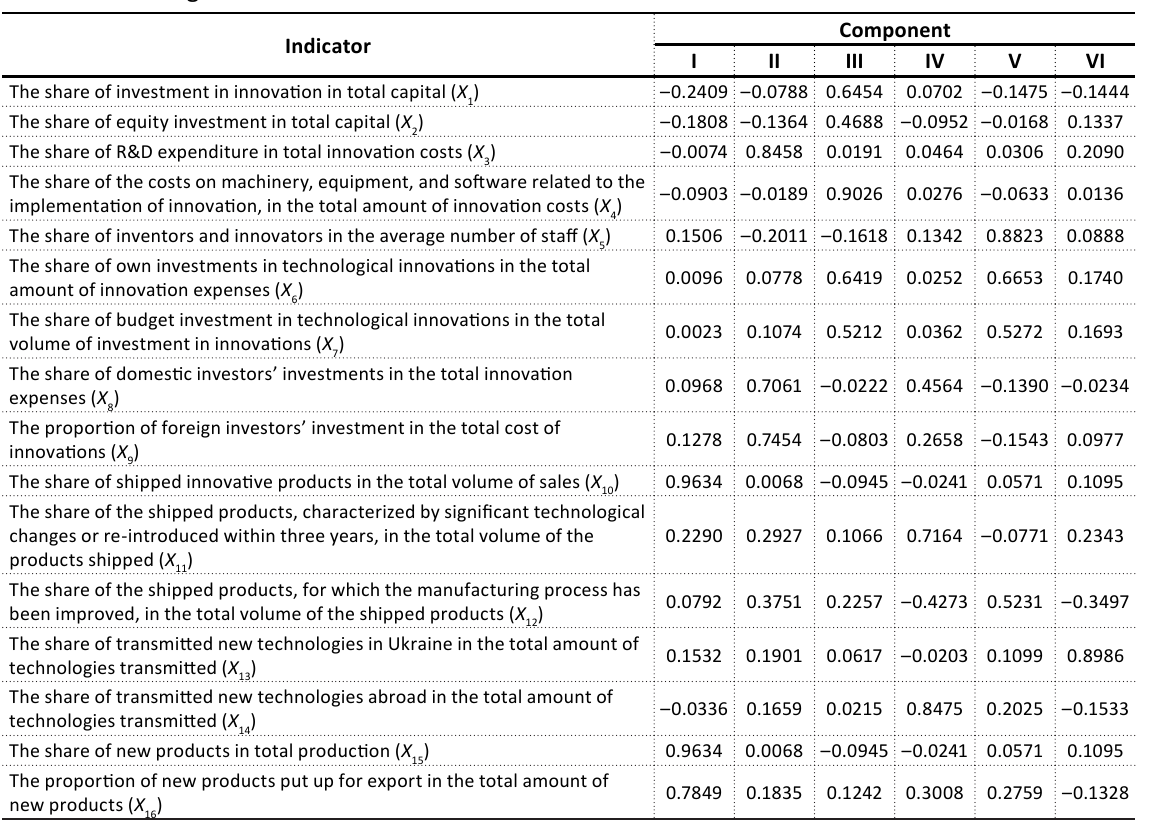
Table 4. Factor loadings of innovation activity indicators of machine-building enterprises of the Kharkiv